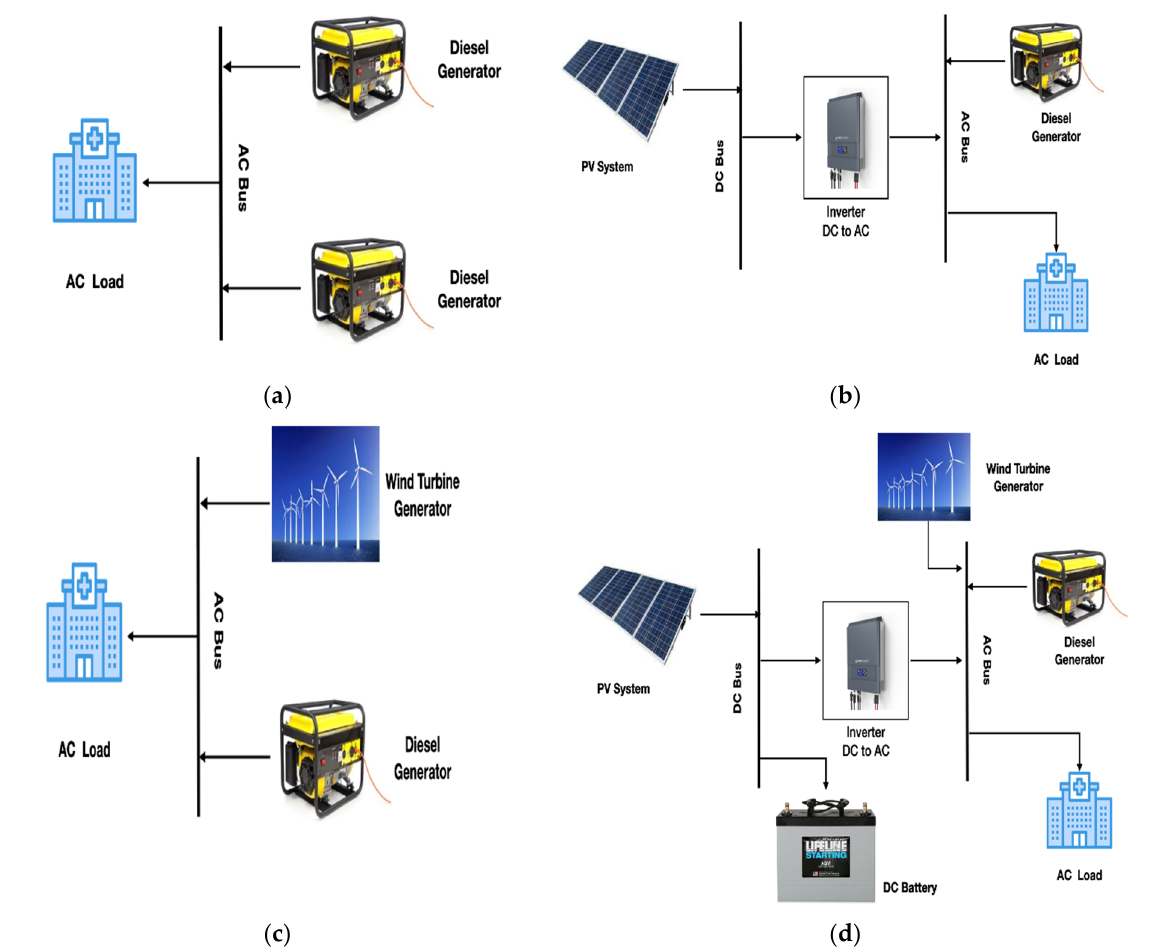
Figure 1. Schematic diagram of the proposed hybrid energy system for different configurations. ( a ) Case 1: Diesel generators only. ( b ) Case 2: Diesel generator with wind turbine. ( c ) Case 3: DG with PV system. ( d ) Case 4: DG, PV, wind turbine and battery.